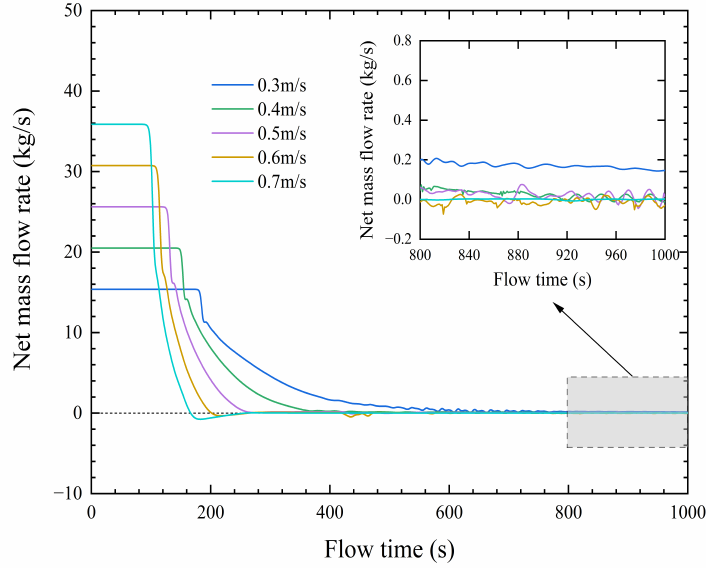
Figure 5. Net mass flow rate changes with flow time (V-inclined pipe L = 80 m d = 0.02 mm).